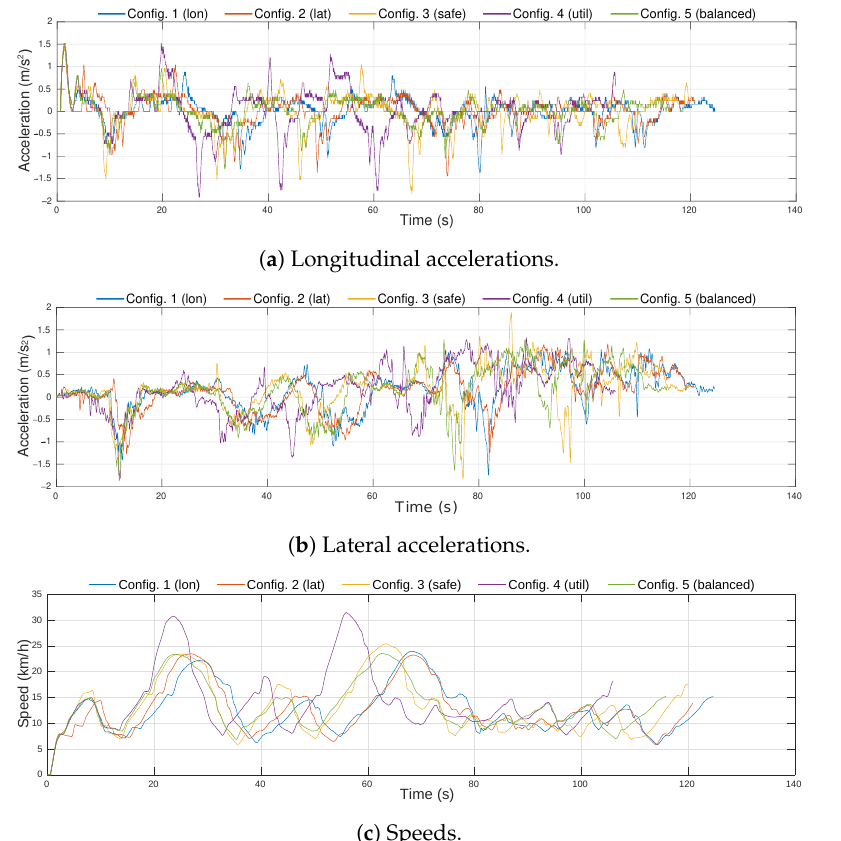
Figure 22. Acceleration and speed profiles for the different configurations executed in the real environment.